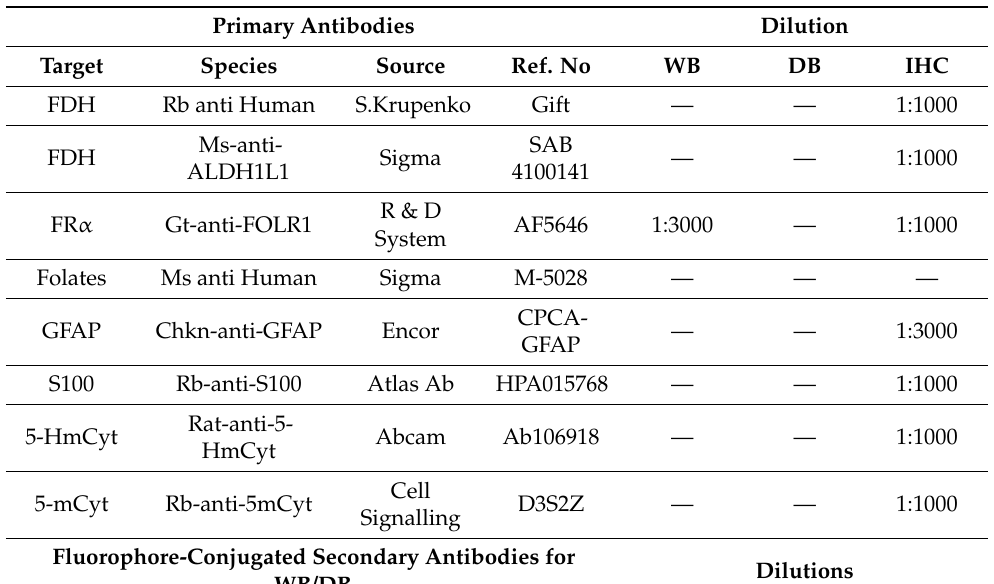
Table 2. Antibodies used in this study. Primary Antibodies Dilution Target Species